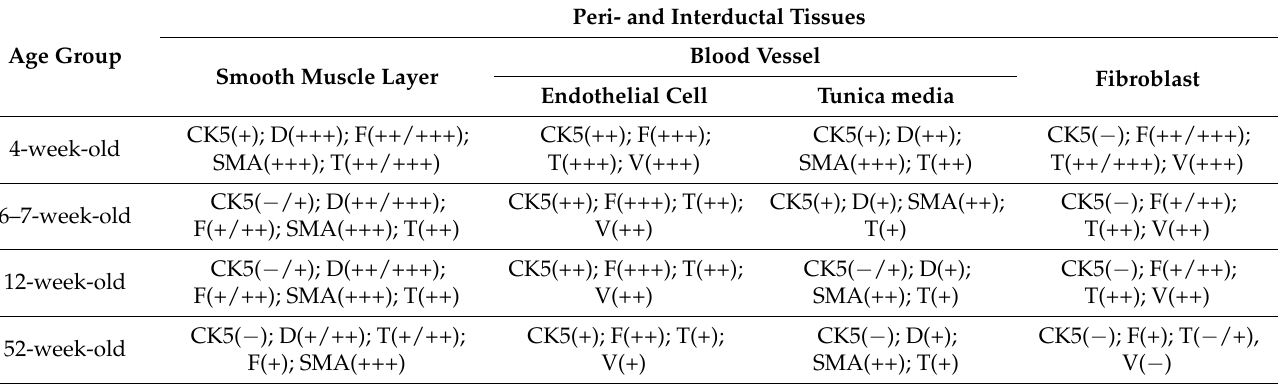
Table 3. Summary of intensities and immunolocalization of the cytokeratin 5 (CK5), desmin (D), fibronectin (F), alpha-smooth muscle actin (SMA), beta-tubulin (T), and vimentin (V) in the peri- and interductal tissue of the testicular excurrent duct system of healthy, captive-bred and raised